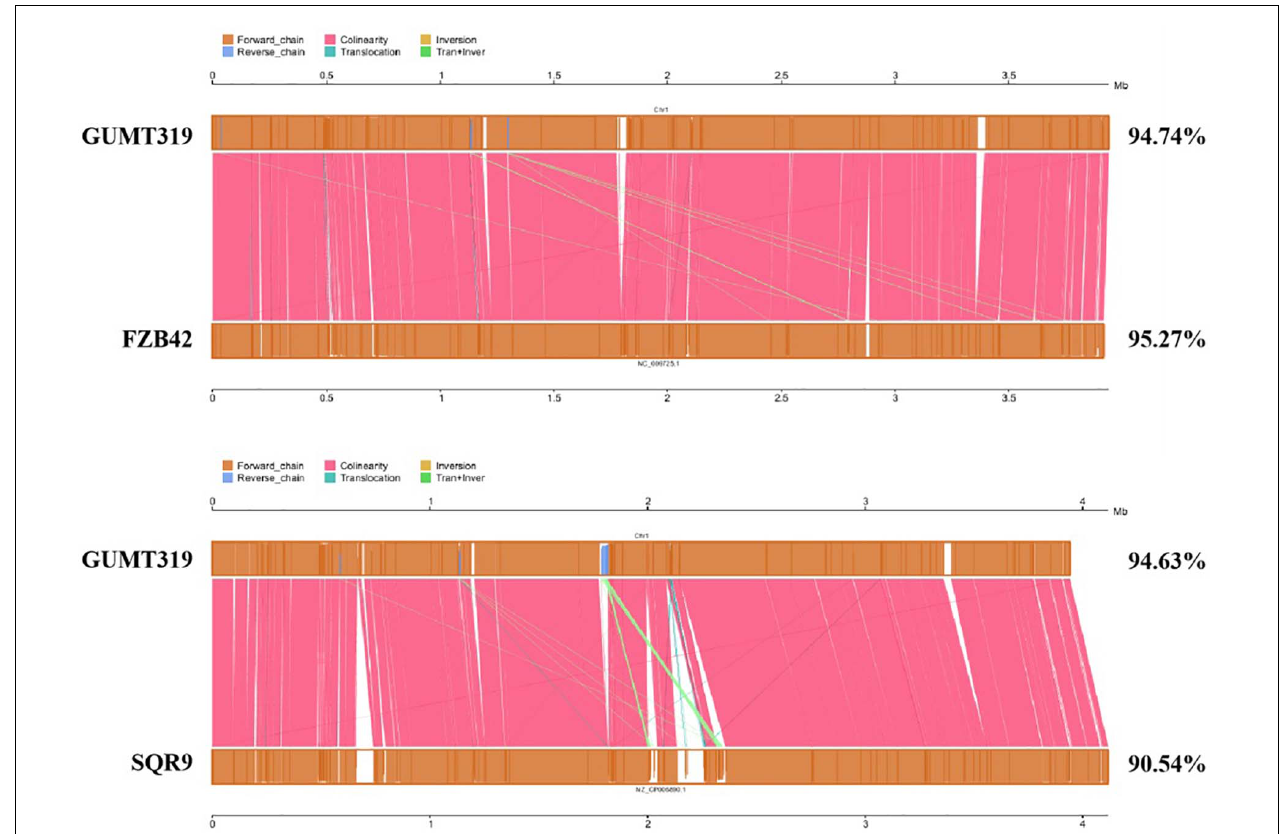
FIGURE 3 | Collinearity analysis of B. velezensis GUMT319 and Bacillus spp.